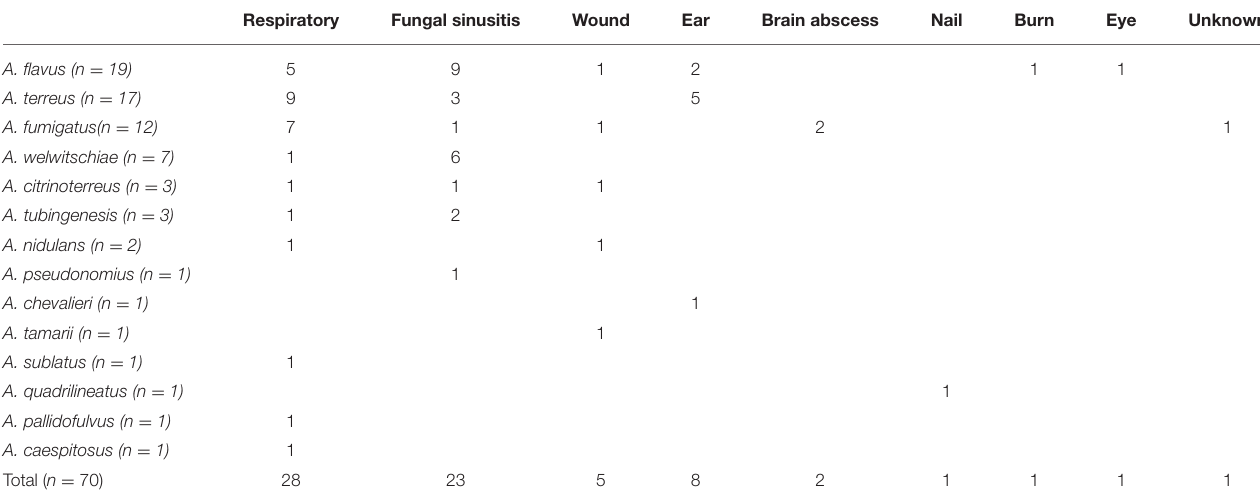
TABLE 3 | Occurrence of Aspergillus spp. in clinical specimens. Respiratory Fungal sinusitis Wound Ear Brain abscess Nail Burn Eye